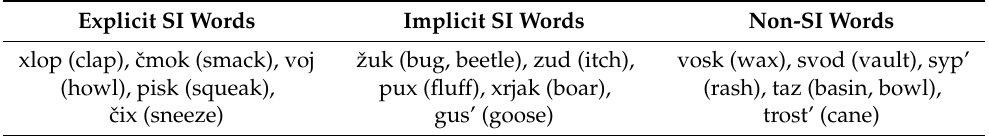
Table 1. Lexical stimuli for EEG